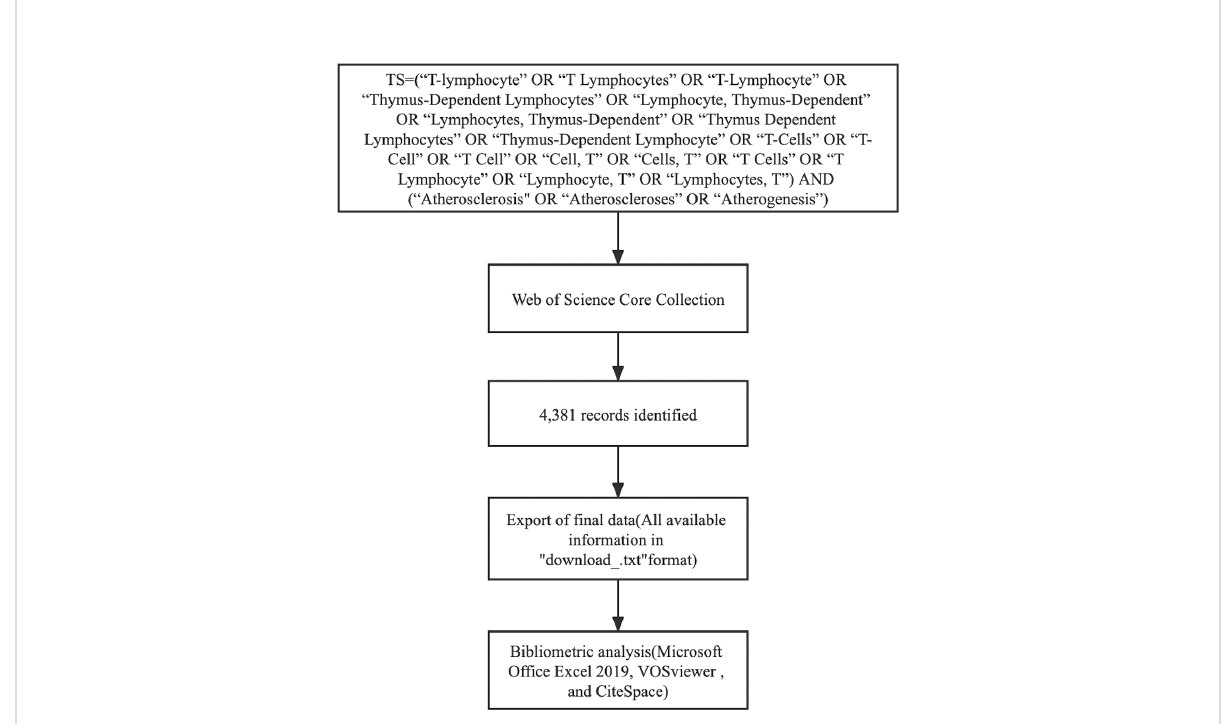
FIGURE 1 The fl owchart illustrating the search strategy and selection process in T cell and